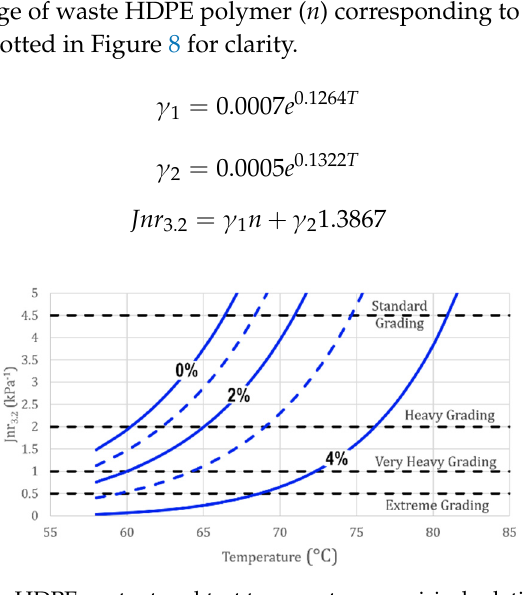
Figure 8. HDPE content and test temperature empirical relationship.